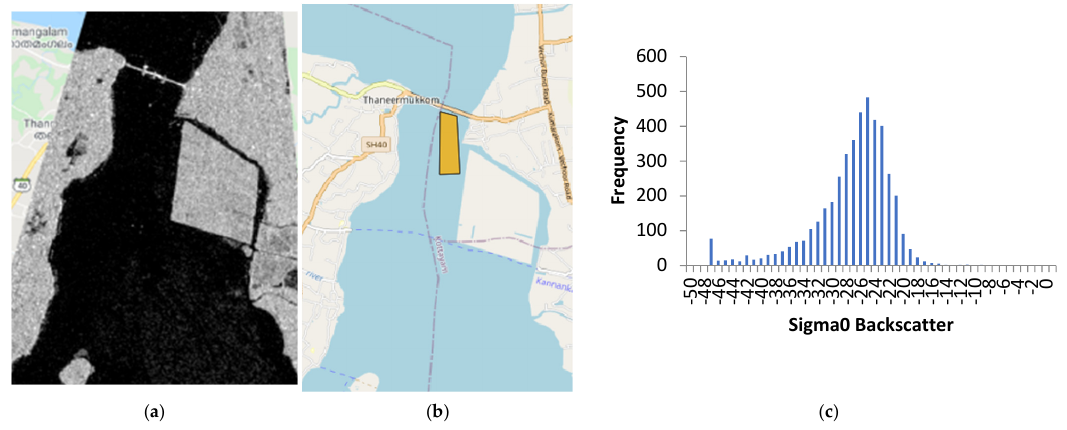
Figure 6. Image from 2 November 2019 in Sentinel-1 V Channel showing reduced water hyacinth on